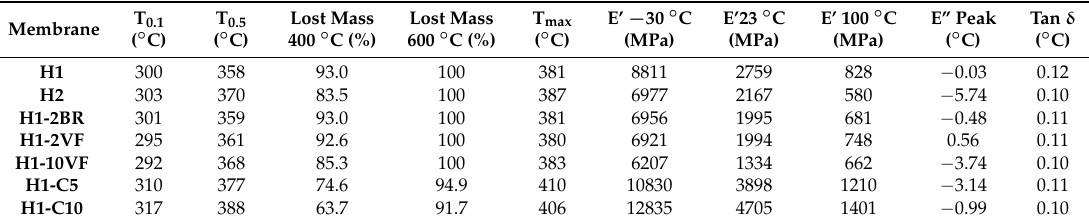
Figure 4. Plots of thermogravimetric analysis (TGA) of membranes with different compositions. Table 3. Thermal stability and dynamic-mechanical analysis. T 0.1 is the temperature at which there was a loss of mass of 10 wt %; T 0.5 is the temperature at which there was a loss of mass of 50 wt %; T max is the temperature of maximum lost mass velocity.